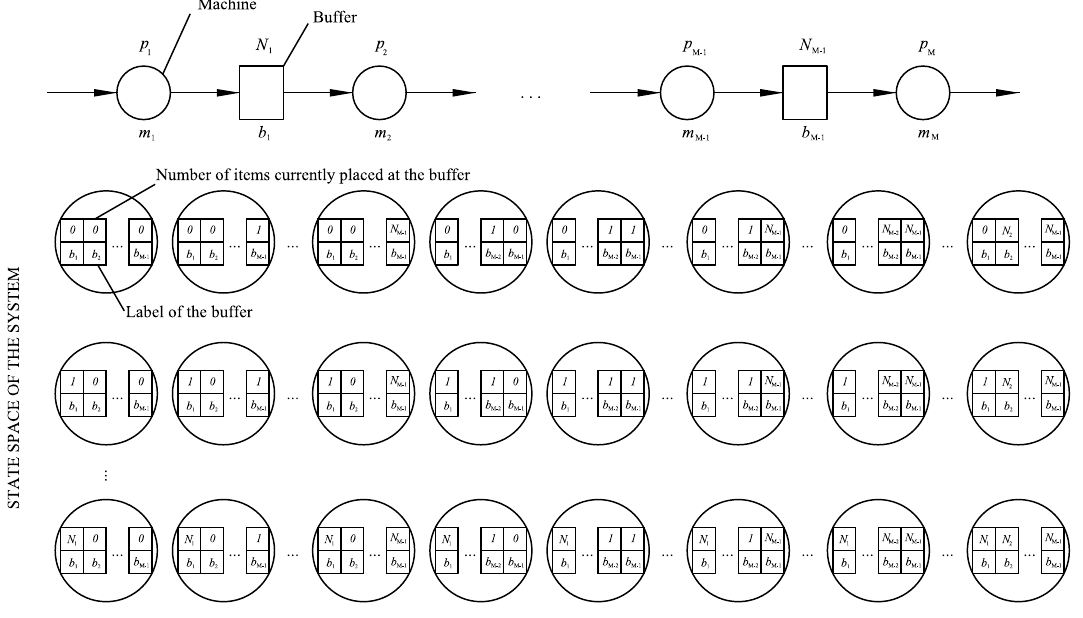
Figure 1. A model of the serial production line including M machines and M -1 buffers with pertaining state space (authors’ work).